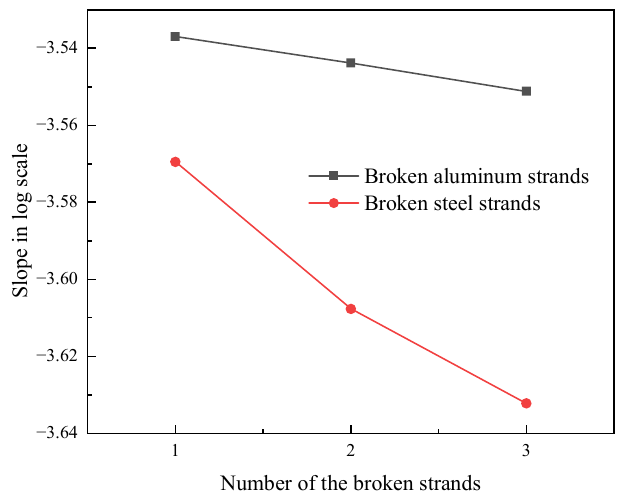
Figure 7. Feature of the slope in the log scale of different broken strands .